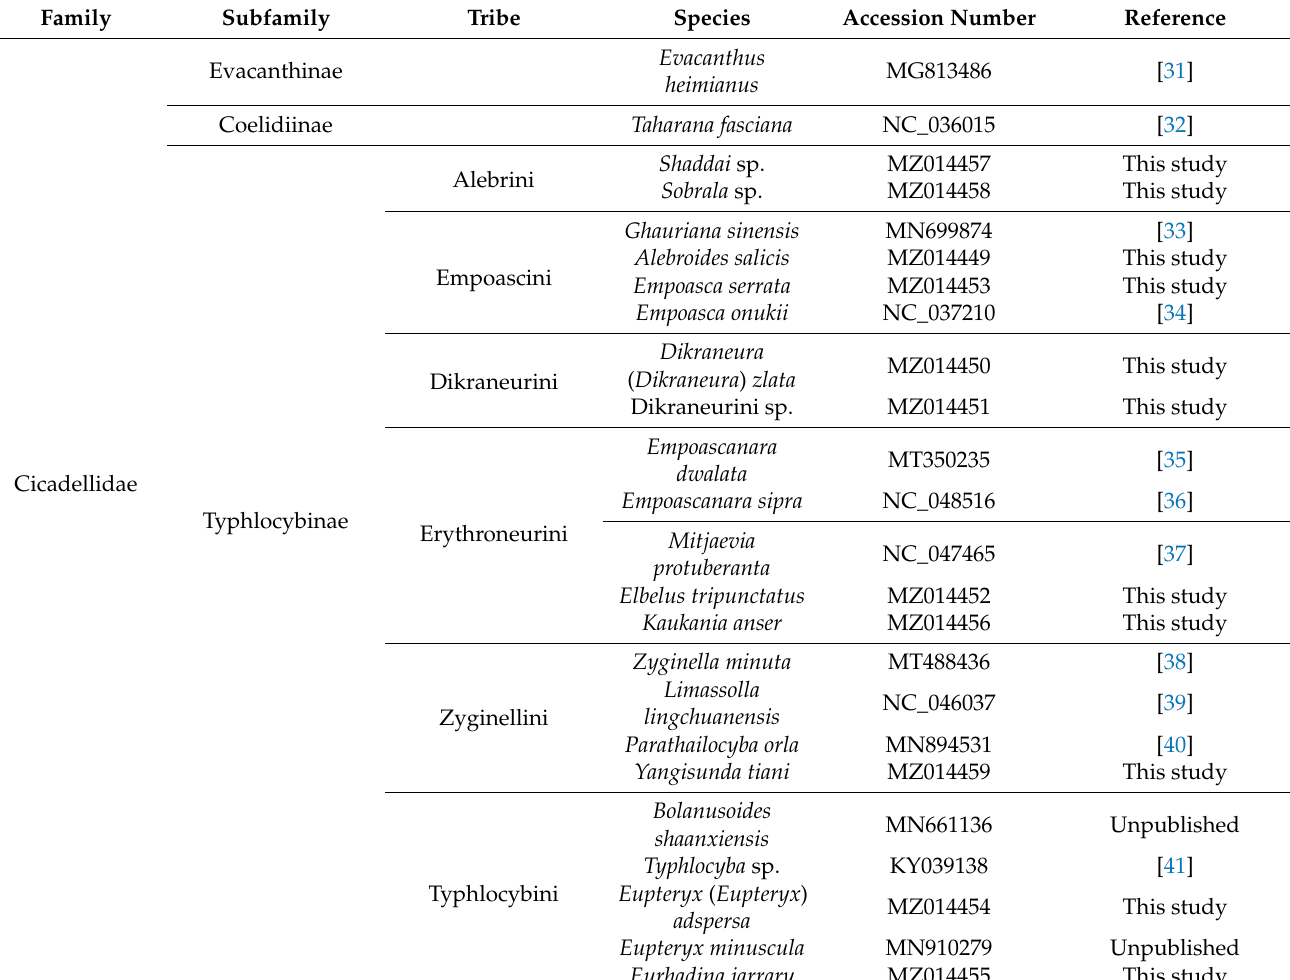
Table 1. Classification and origins of the mitogenomic sequences used in this study.